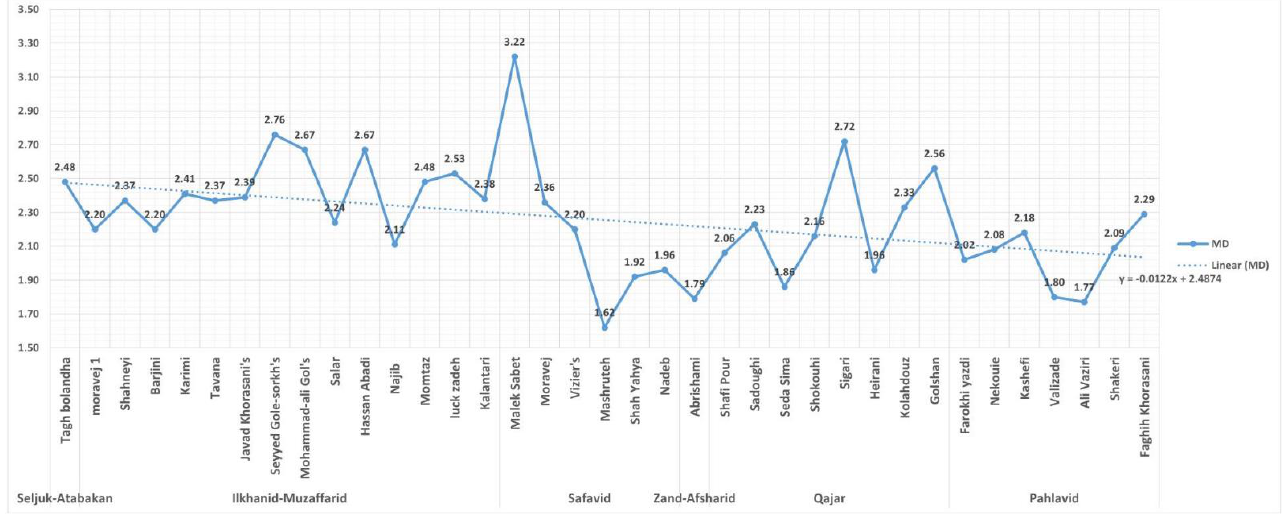
Figure 9. Mean Depth ( MD ) results and trendlines for the 37 houses, presented chronologically by era. The highest RA and RRA (Figure 10) values are in the data for Javad Khorasani’s House (Ilkhanid period) at 1.25 and 0.4, respectively, and the lowest are in Heirani House (Qajar period) at 0.06 and 0.36, respectively. Interestingly, the normalized RRA results for the two are similar (0.4 verses 0.36), which may reflect the similar ratio of courtyards to rooms identified previously ( K G0 / K ). The difference in results between the smallest and largest values is relatively pronounced, and with the increase in scale, rooms become less private, because the addition of further yards produces more perimeter spaces, which are higher integration zones. On average, over time, spaces have become more integrated around the courtyards and arguably, privacy has been reduced because of this. This might reflect a simplification of environmental design strategy over time, as well, with deeper rooms being less